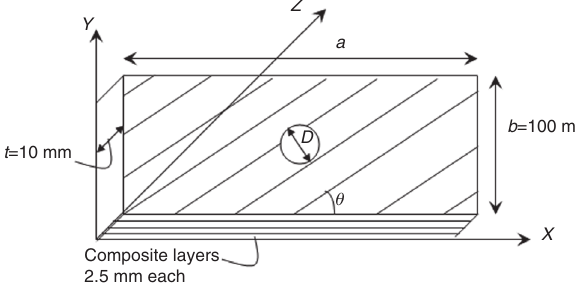
Figure 1 Schematic representation showing laminated geometric dimensions.